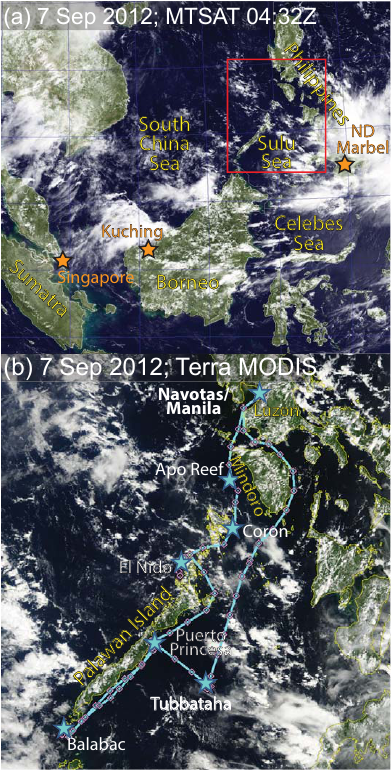
Figure 1. Overview of the study domain. (a) Regional MTSAT false color visible image of 7 September 2012 – the clearest day of the mission. AERONET sun photometer sites used in this analysis are also marked. (b) Cruise track with major sampling locations starred. Minor ticks during transits are 3h